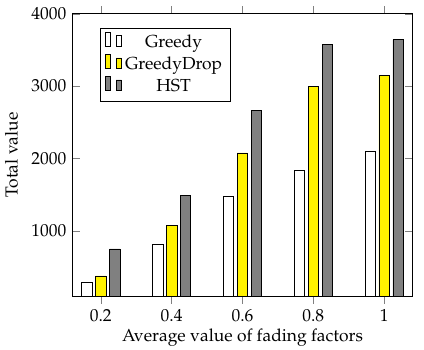
Figure 12. The effect of different average value of v i for non-FIFO tasks.